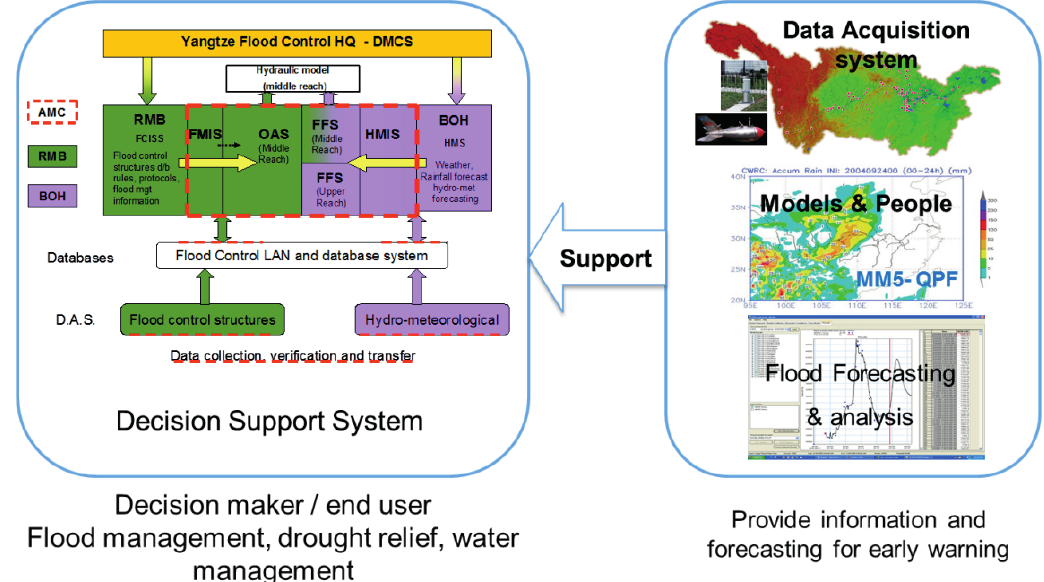
Fig. 6 Non-engineering measure of hydro-meteorological forecasting as decision support for flood and water resources